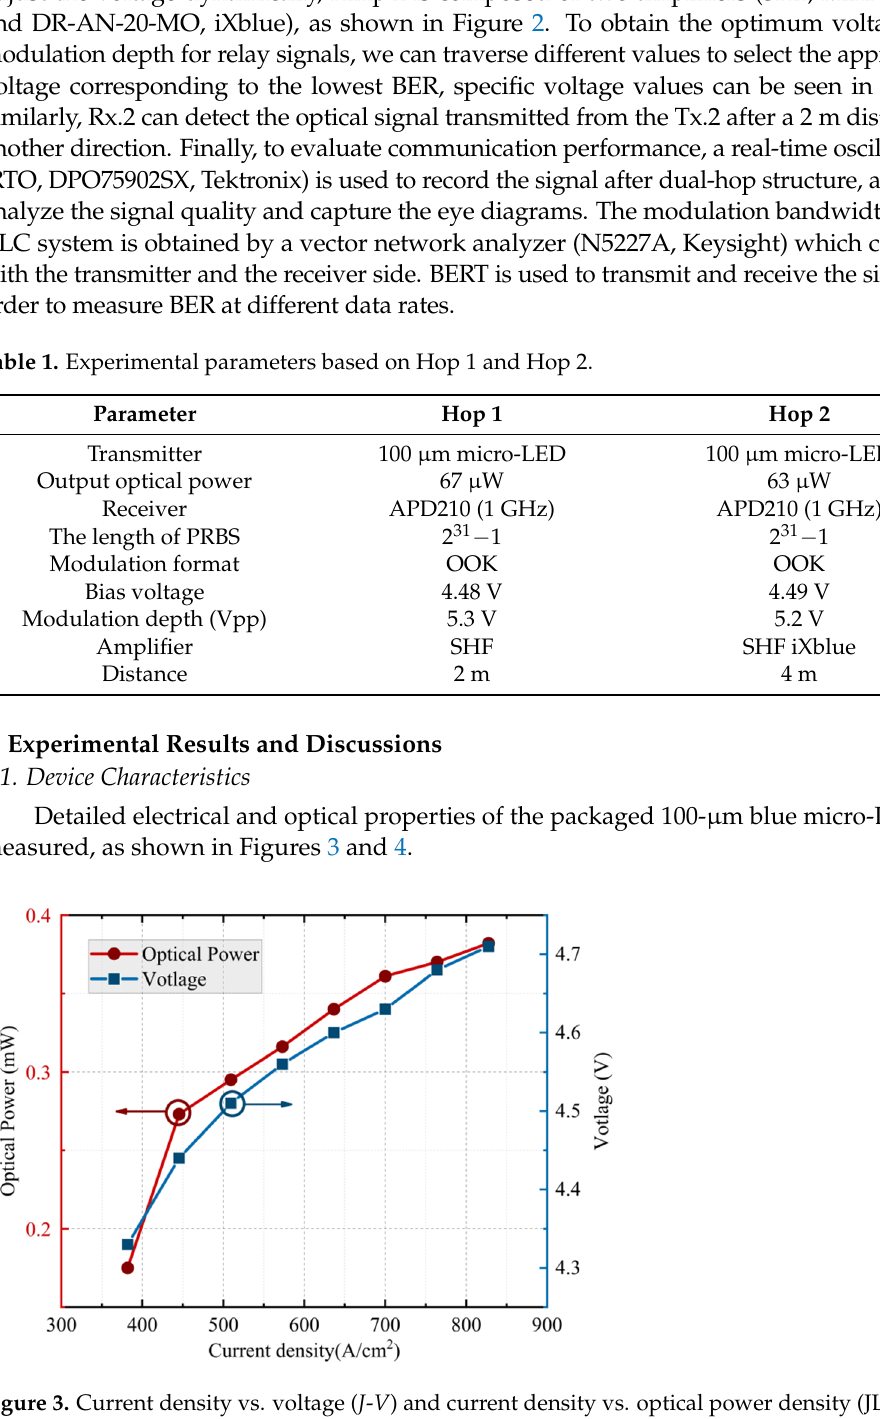
Figure 3. Current density vs. voltage ( J - V ) and current density vs. optical power density (JL) curves of the package 100- μ m micro-LED.